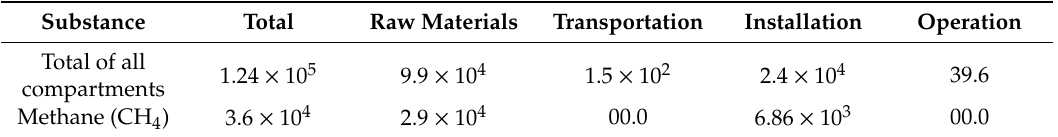
Table 12. Analyzing ‘TWF-Phases’; Method: TRACI / Characterization / Smog Category / Methane (CH 4 ), Fossil, µ m, Unit kg (H + moles